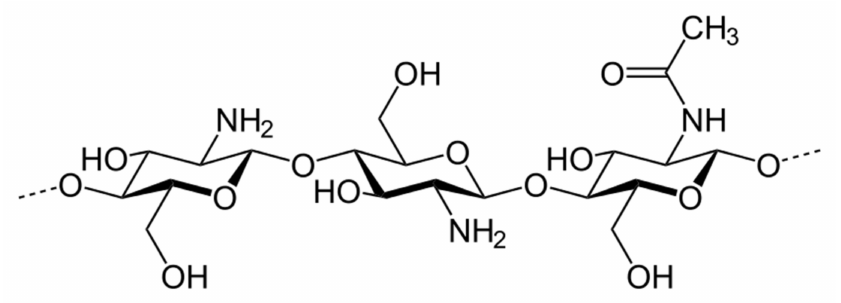
Figure 1. Chemical structure of